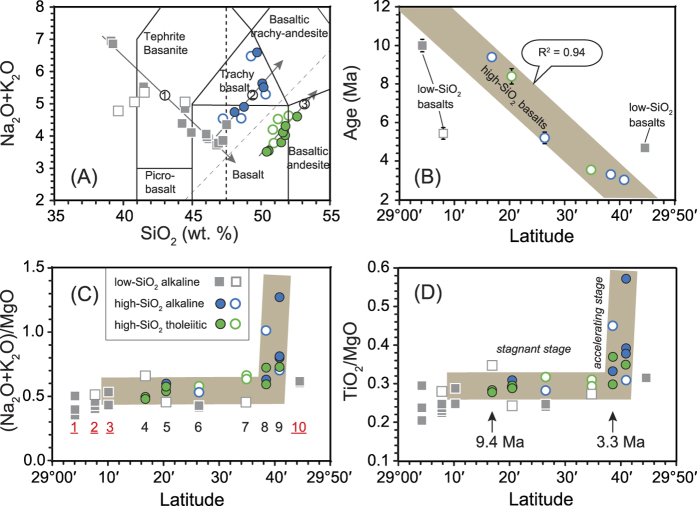
(A) Plot of SiO2 vs. total alkali. 1, 2, and 3 represent the trends of low-SiO2 alkaline basalt, high-SiO2 alkaline basalt, and high-SiO2 tholeiitic basalt, respectively. (B–D): Plots of latitude vs. each of age, (Na2O + K2O)/MgO, and TiO2/MgO, respectively. Ar-Ar and K-Ar ages with errors smaller than symbols are shown without error bars. Closed symbols represent data of the present study, while open symbols represent published data15. Sample locations are shown as numbers in (C).